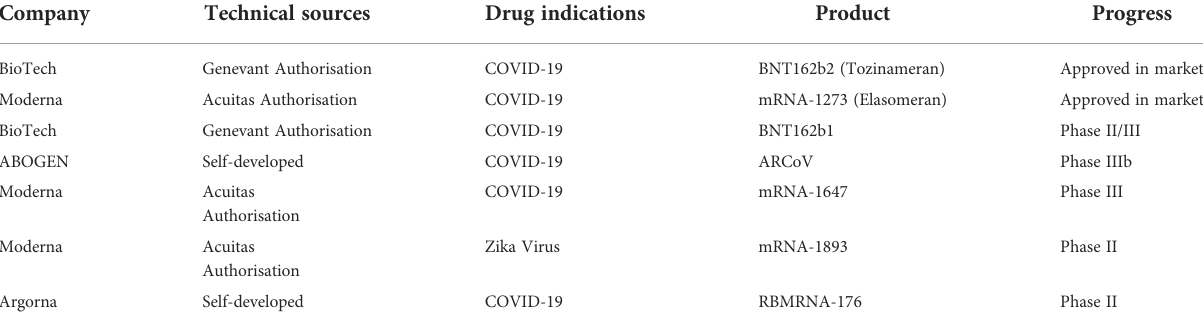
TABLE 4 China and international mRNA-LNP